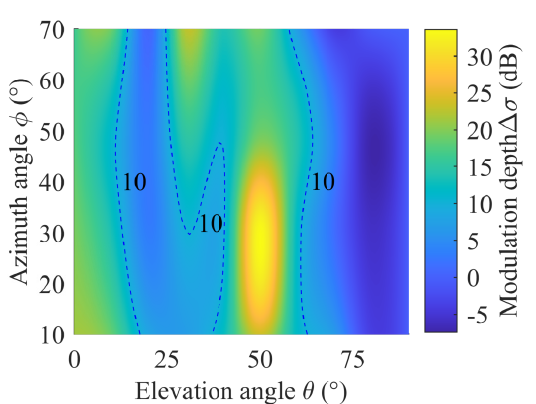
Figure 7. RCS modulation depth at the resonant frequency.